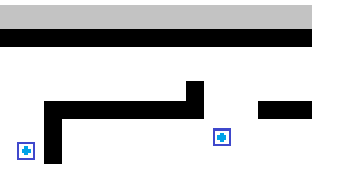
Fig. 7. Planning mode with automatic waypoint is a solution to find a small set of points enough for the agents to reach their goal.